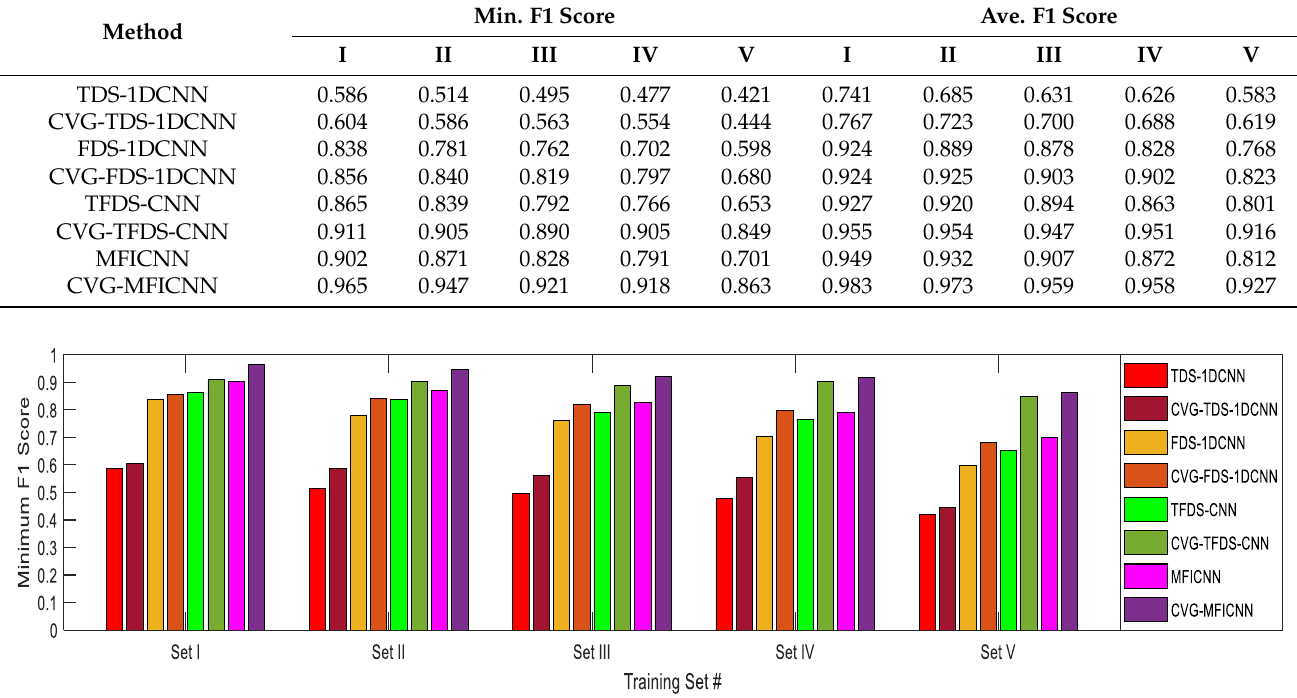
Figure 14. Comparison of minimum testing F1 scores of models trained using different methods and based on different training sets.